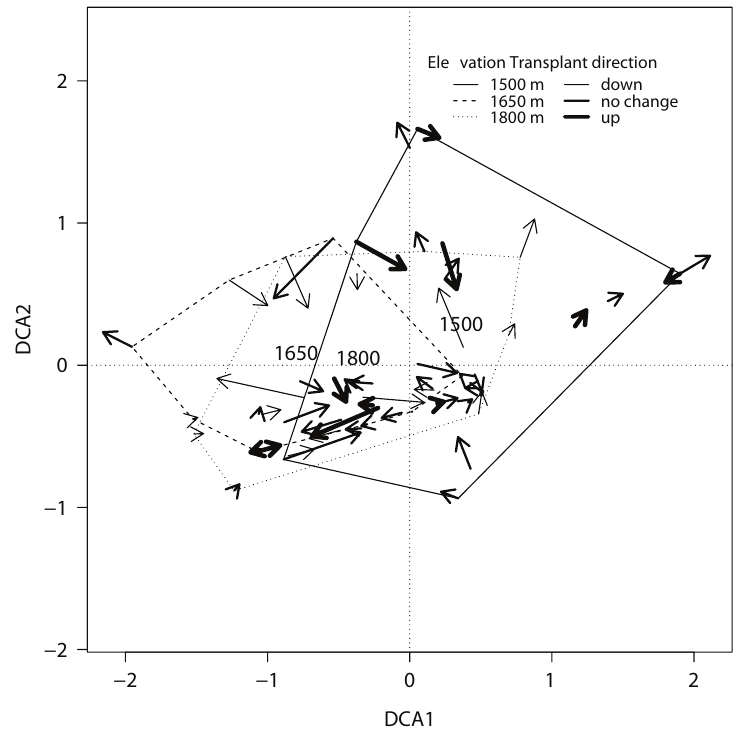
Figure 3. First two axis of a Detrended Correspondance Analysis (DCA) on the species composition of epiphyte mats both before and after mats were transplanted. Arrows connect the compositions of individual mats before and a year after transplantation. Line width depicts direction of transplanting. Hulls are drawn around the 2005 composition of mats that originated at the same elevation, and labels are placed at the hull centroid.